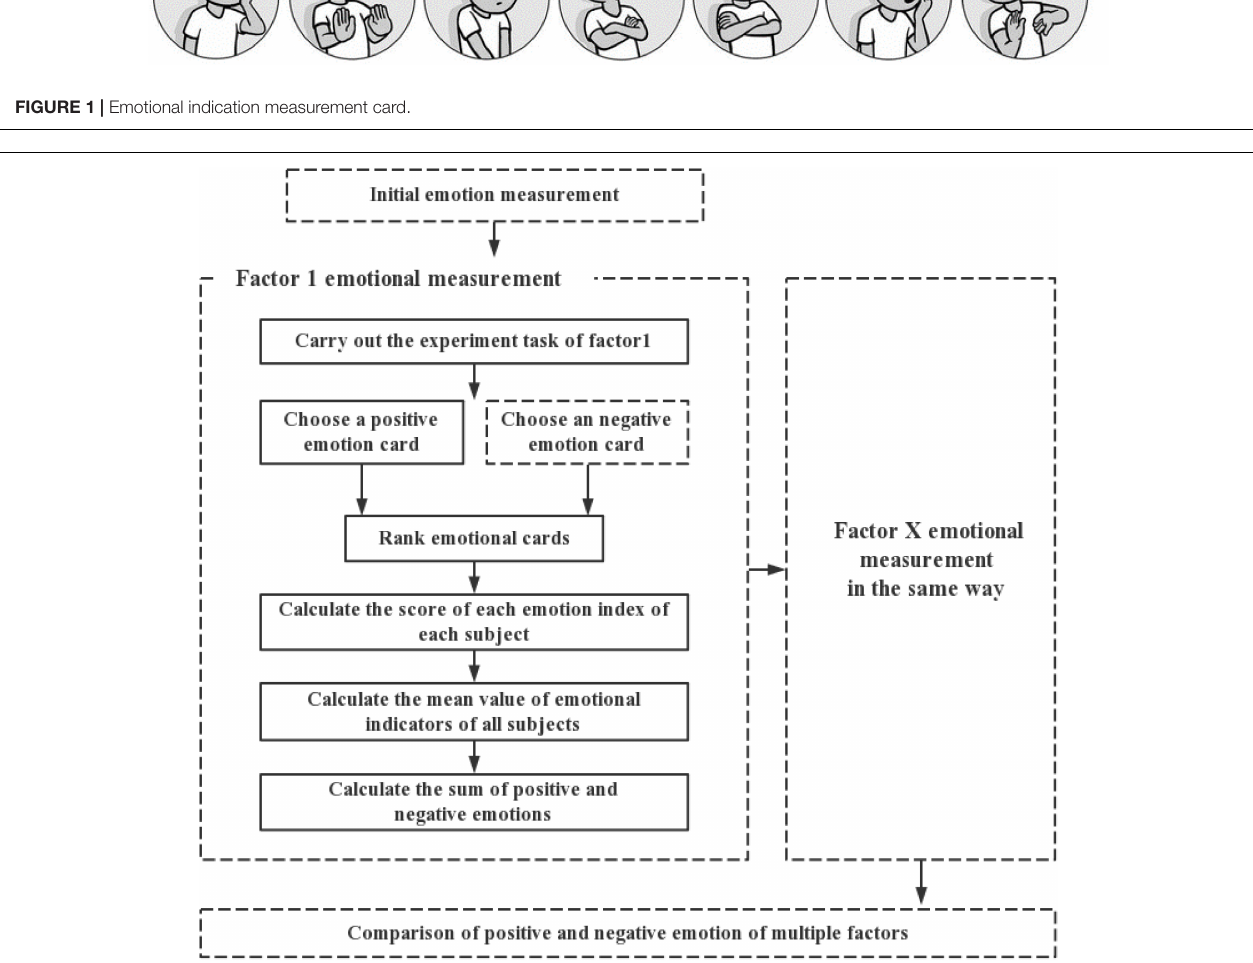
FIGURE 2 | Extended product emotion (E-PrEmo) measurement